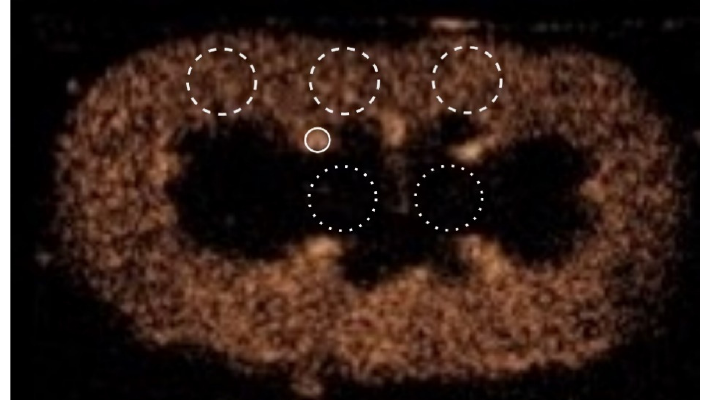
Figure 1. Illustration of the position of the regions-of-interest on a contrast-enhanced ultrasound image of a healthy cat’s kidney. Cortex regions-of-interest are enclosed by a white striped line, medulla regions-of-interest by a white dotted line, and the region-of-interest surrounding the interlobar artery by a solid white line.